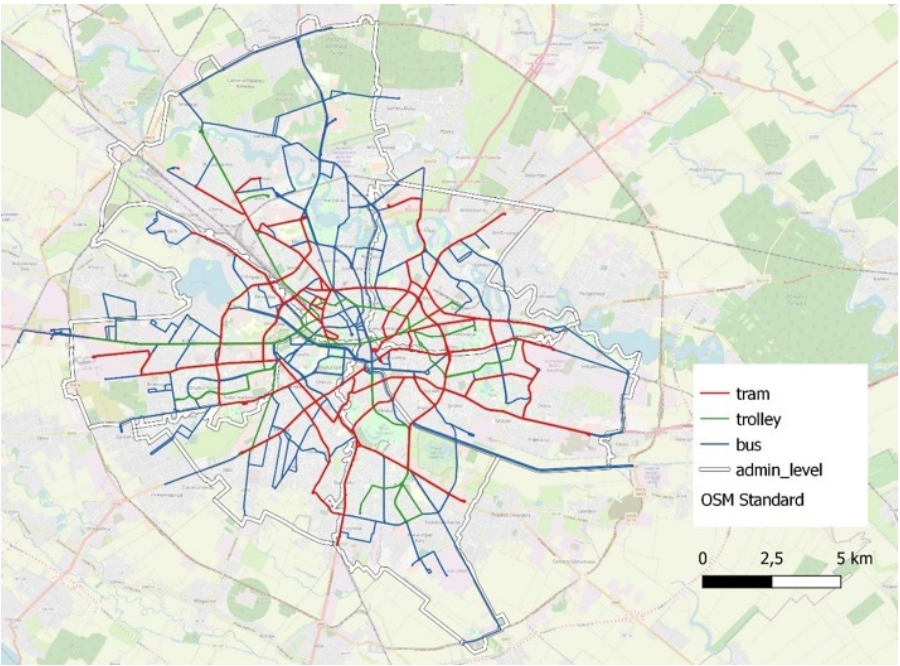
Figure 5. Administrative area and public transport network in Bucharest (blue line—bus network; green line—trolleybus network; red line—tram network) (© OpenStreetMap contributors).